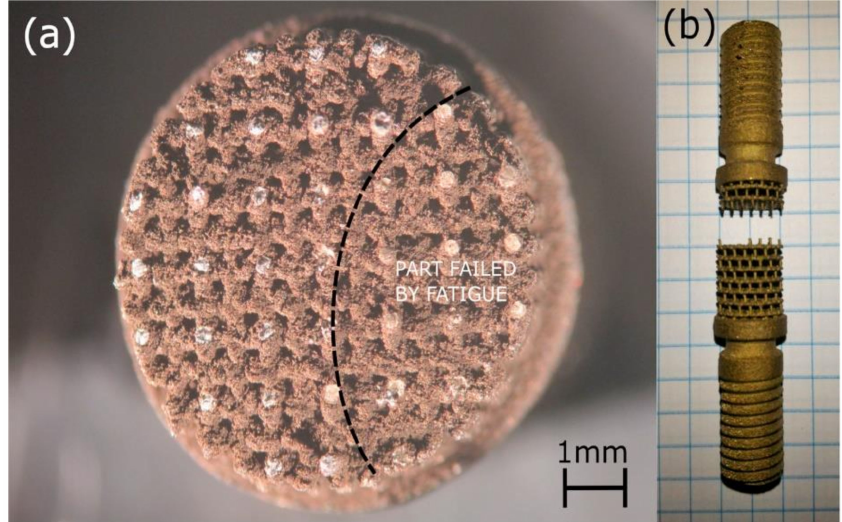
Figure 19. Fractured section of a fatigue test specimen (as-build CUB S). ( a ) the struts failed by fatigue (partly failed by fatigue) are golden because of the heat tinting. ( b ) fractured specimen after a fatigue test. The fracture is away from the bulk/ cellular structure. Reprinted with permission from ref. [79]. 2016,